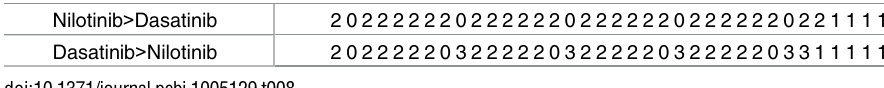
Table 8. The optimal treatment schedules with different drug